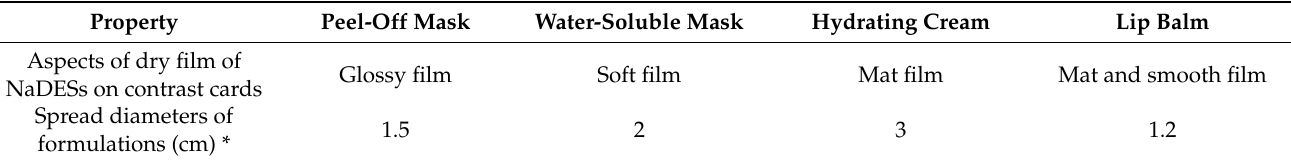
Table 13. Film-forming properties of NaDESs and their resulting